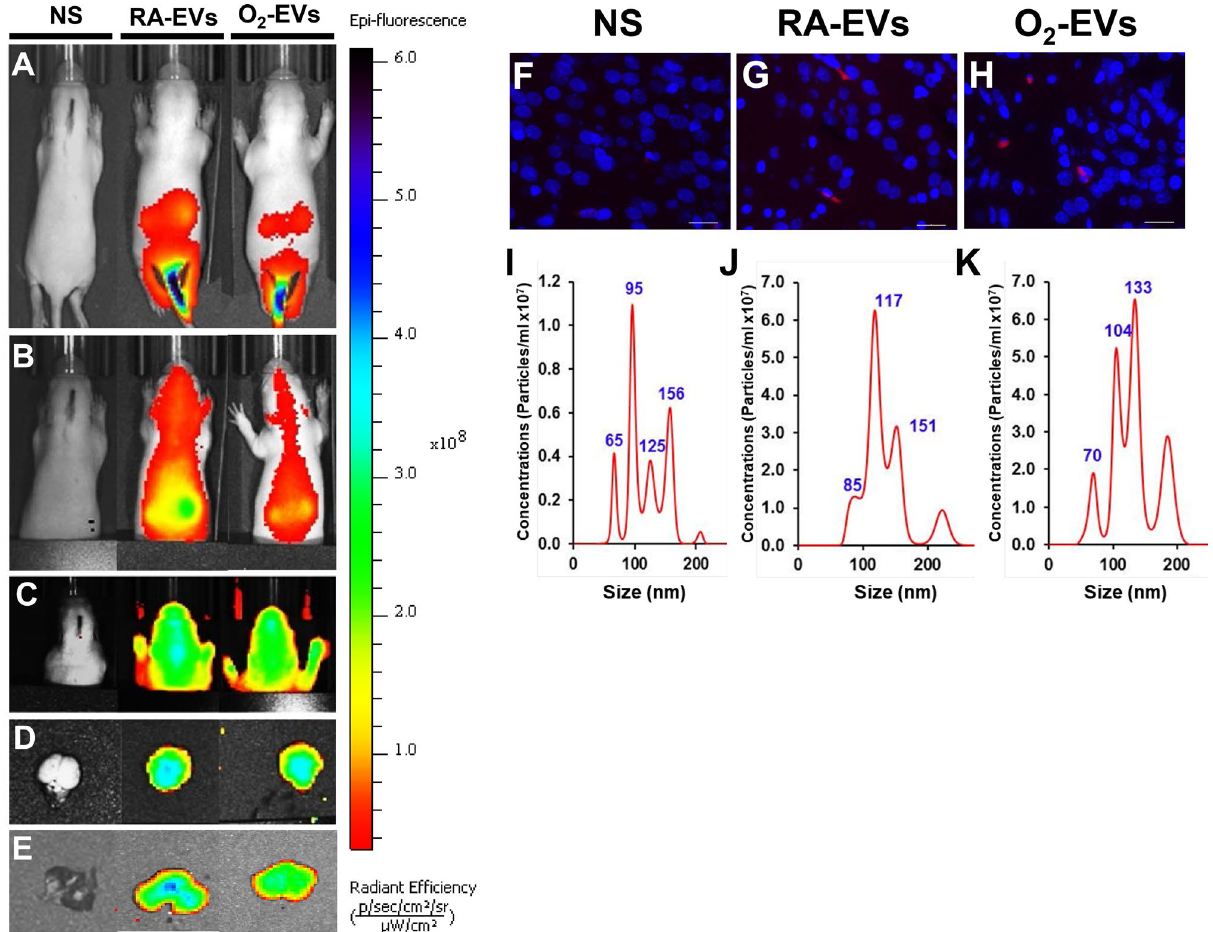
Figure 2. Adoptively transferred circulating EVs track to the lung and brain of normal neonatal rats. Exo-glow dye sham-labeled normal saline (NS), labeled RA-EVs or O 2 -EVs was injected via tail vein into normal neonatal rats at P7. In vivo imaging was acquired at 15 min ( A ), 1 h ( B ) and 4 h ( C ). Brains ( D ) and lungs ( E ) were dissected at 4 h for ex vivo imaging. In vivo near IR signals were detected in the brain and lung regions at 1 h and 4 h and also ex vivo in dissected brain and lung tissues at 4 h. Dil sham-labeled NS, labeled RA-EVs or O 2 - EVs were injected via tail vein into normal neonatal rats at P7 and brain tissues and CSF samples were collected 24 h later. Brain sections from NS injected rats ( F ) were negative but both RA-EVs injected ( G ) and O 2 -EVs ( H ) injected animals showed Dil signals (red flourecence). Nanosight tracking of EVs isolated from the CSF showed increased EV particle concentrations in CSF from RA-EVs ( J ) and O 2 -EVs ( K ) injected rats compared to NS injected rats ( I ). Scale bar: 50